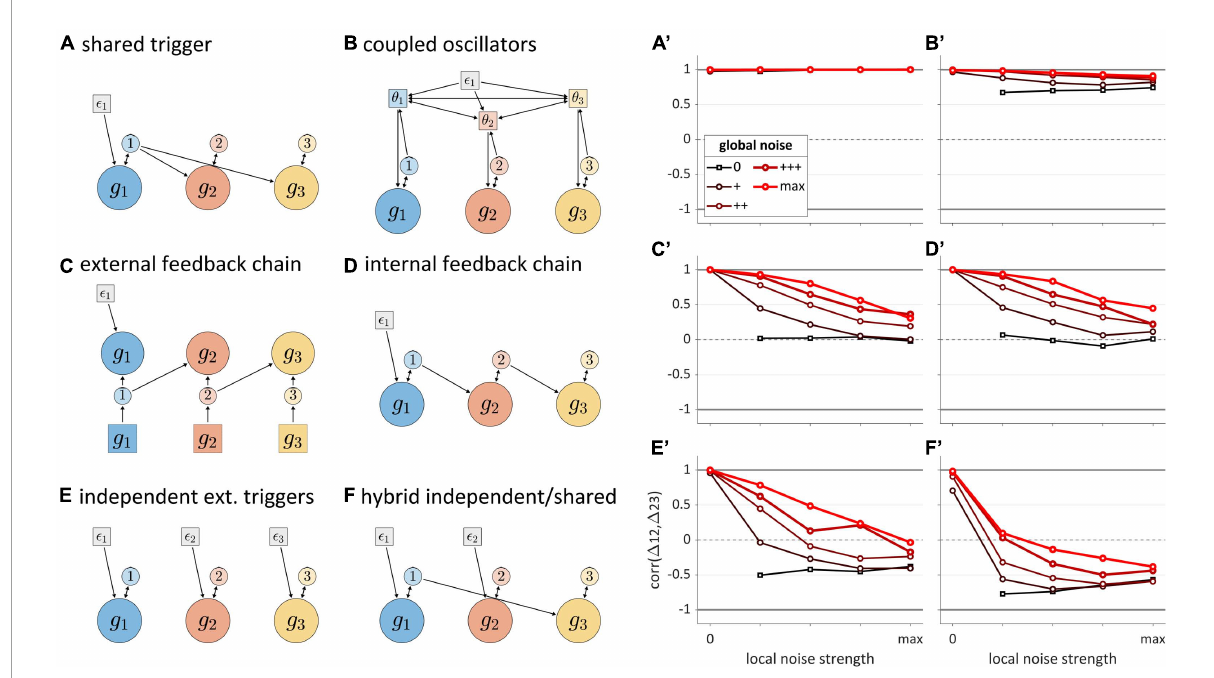
FIGURE8 Noise-related correlation patterns for a variety of three-gesture systems. Panels (A–F) show model schemas and corresponding panels (A’–F’) show correlations of intervals between initiation of gestural systems. Local noise levels increase along the horizontal axes, while global noise levels are indicated by the lines in each panel. Cases where both global and local noise are zero are